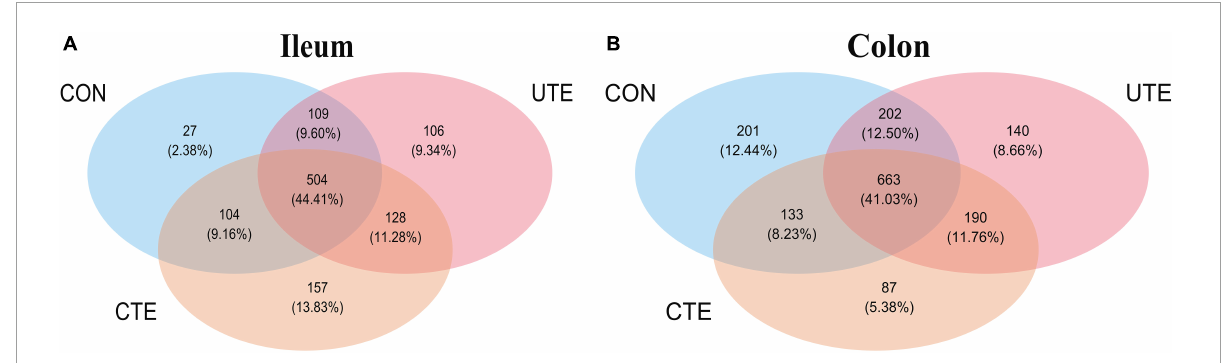
FIGURE4 Venn diagram of the OTUs among the three treatments of bacteria in the ileum (A) and colon (B) . CON, sheep fed with the basal diets; CTE, sheep fed with the basal diets plus 400 mg/kg coated trace elements; UTE, sheep fed with the basal diets plus an equal amount of trace elements in uncoated form. n = 4.